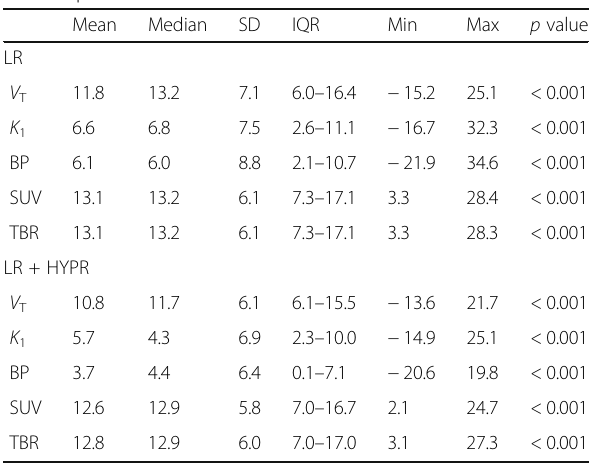
Table 2 Relative changes (%) in kinetic parameter estimates and simplified metrics after PVC